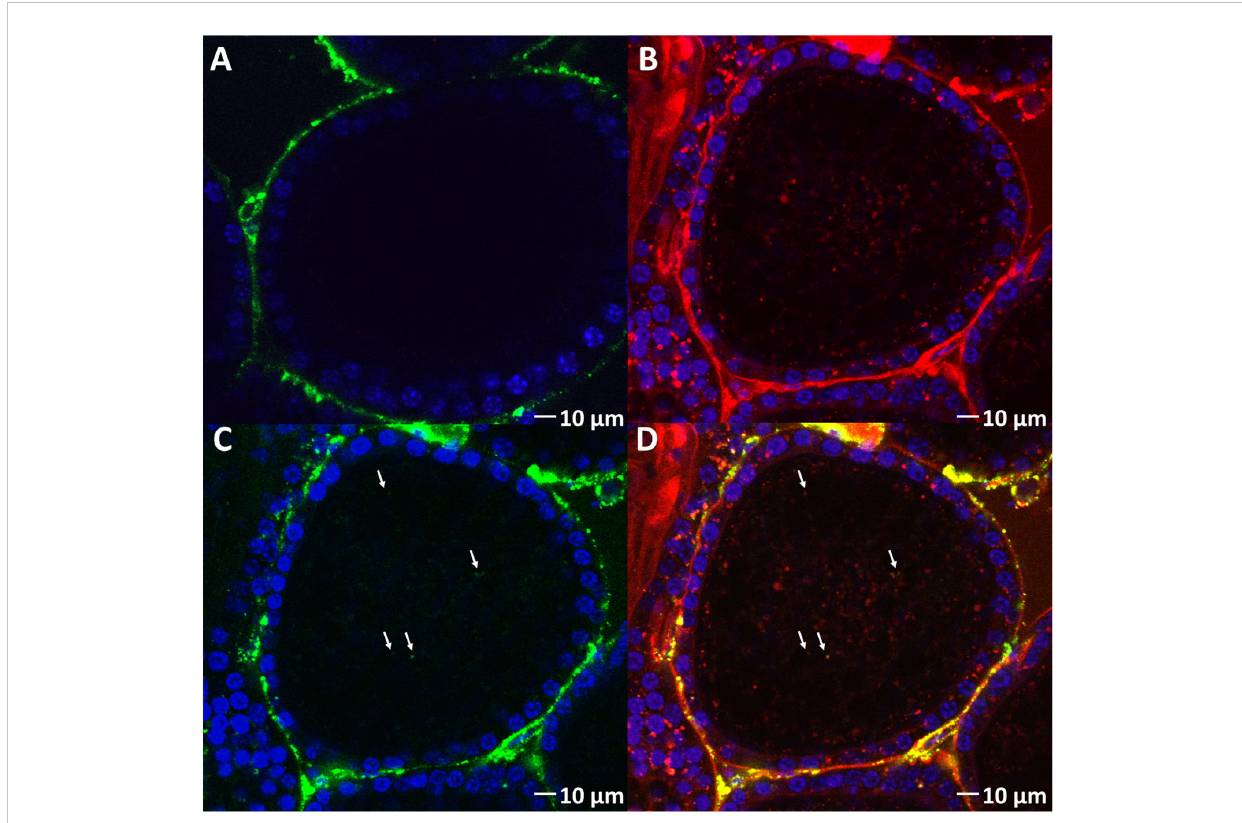
FIGURE 5 (KH) 9 VgP-TAMRA can piggyback dsRNA-FITC into oocytes in vitro . (A) Fluorescence images of oocytes from ovary pieces incubated with dsRNA- FITC. (B) Red fl uorescence image of an oocyte from ovary pieces incubated with (KH) 9 VgP-TAMRA mixed with dsRNA-FITC. (C) Green fl uorescence image of the same preparation as in B; white arrows directed toward green puncta indicate the endocytosis of dsRNA. (D) Overlay of (B , C) images; white arrows directed toward orange puncta indicate the endocytosis of dsRNA and peptide